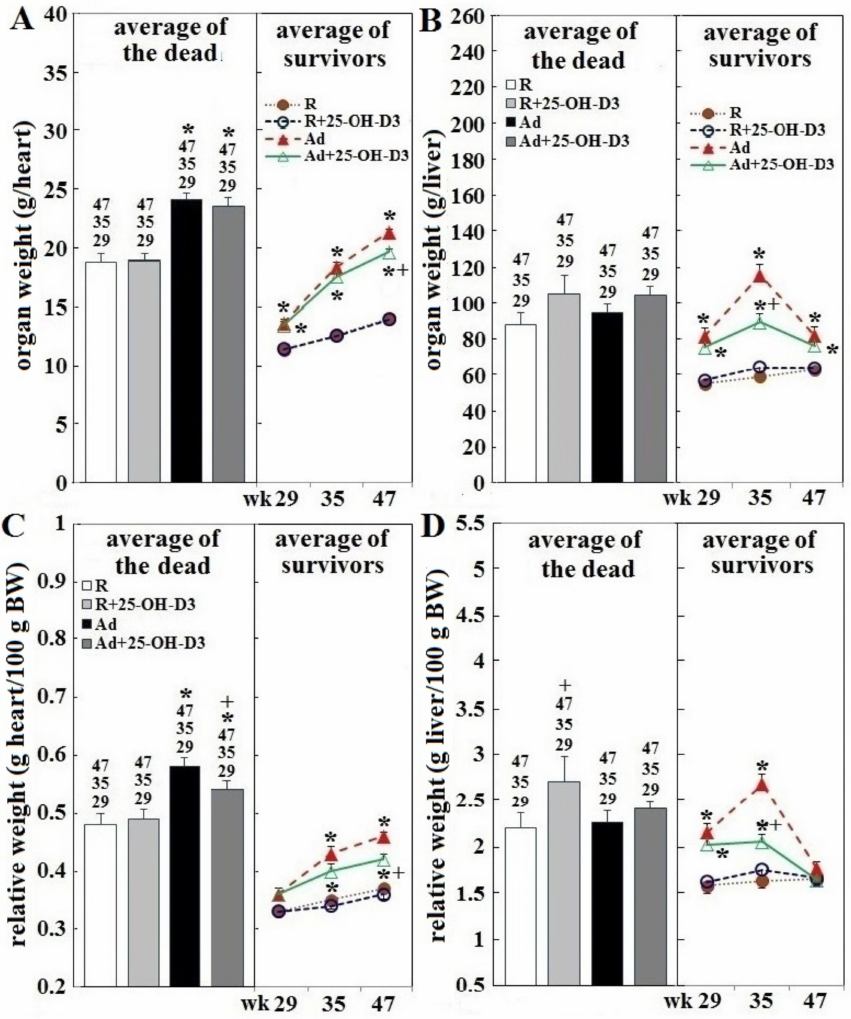
Figure 3. E ff ect of dietary 25-OH-D3 supplementation on absolute and relative heart and liver weights of broiler breeder hens provided with restricted or ad libitum feed intake. Hens experiencing sudden death were necropsied within 24 h to determine body composition. Mean ± SEM of actual (panels A , B ) and relative ( of 100 g BW, panels C , D ) heart and liver weight (n = 19, 12, 78, and 57 in R, R + 25-OH-D3, Ad, Ad + 25-OH-D3 group, left part) are shown in comparison with those of live hens sampled at age of 29, 35, and 47 weeks for tissue collection (n = 4, 7, 7 hens for each group, respectively, right part). *; significant di ff erence due to feeding level (vs. corresponding R hens, p < 0.05). + ; significant di ff erence by 25-OH-D 3 inclusion (vs. R or Ad hens, p < 0.05). Numbers shown above means in the left part of each panel (29, 35, or 47) indicate significant di ff erence vs. corresponding surviving hens sampled at the indicated age ( p < 0.05). R; restriction, Ad; ad libitum, 25-OH-D 3 ;